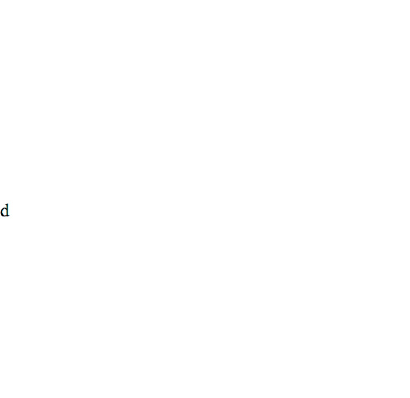
Figure 24. Radar diagram for ranking design options based on service life, charging rate, weight, and energy density.